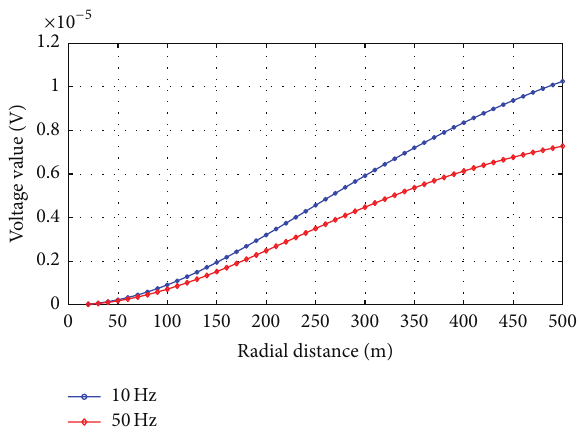
Figure 8: Curves of the radial component of the electric field magnitude with the frequency.